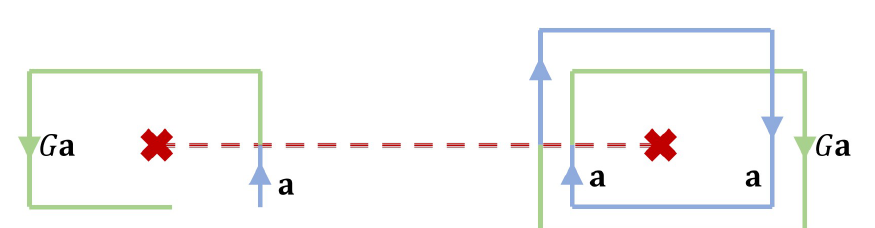
Figure 1: A G = (cid:90) twist defect switches the layer index, which can no longer be 2 assigned globally due to the topological obstruction, but can still be assigned